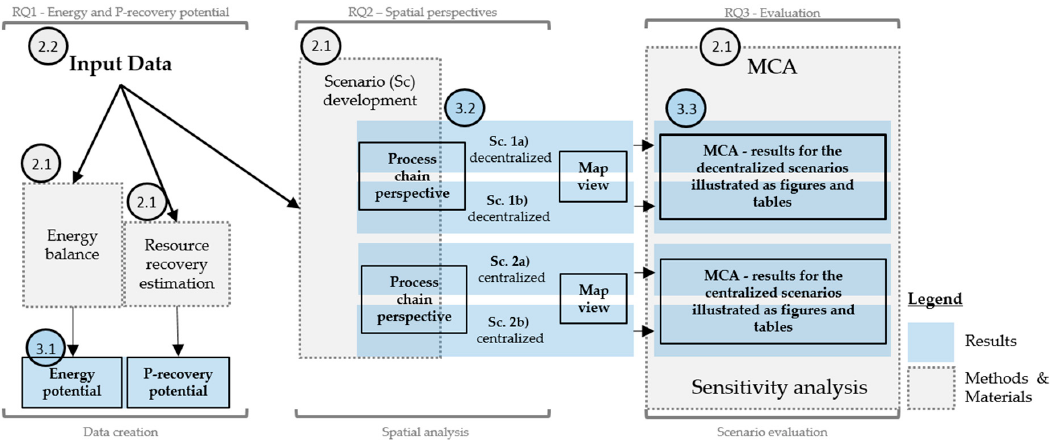
Figure 1. Overview to the five methods used for the case study, data flow, and paper structure. The numbers refer to the section of the paper where the item is discussed.